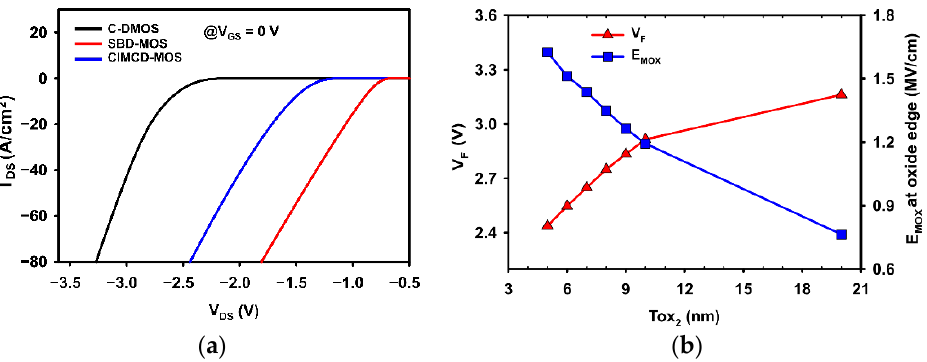
Figure 5. On-state characteristics of C – DMOSFET, SBD – MOSFET, and CIMCD – MOSFET.